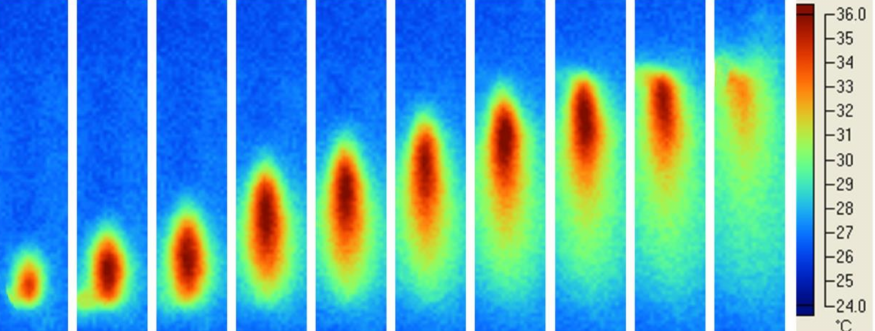
Figure 5. Light curing of DEI composite: typical temperature profiles using Mode I and LED blue Mectron unit. The large spot beam light along the whole length of the specimen was observed. Photograms were taken every 4